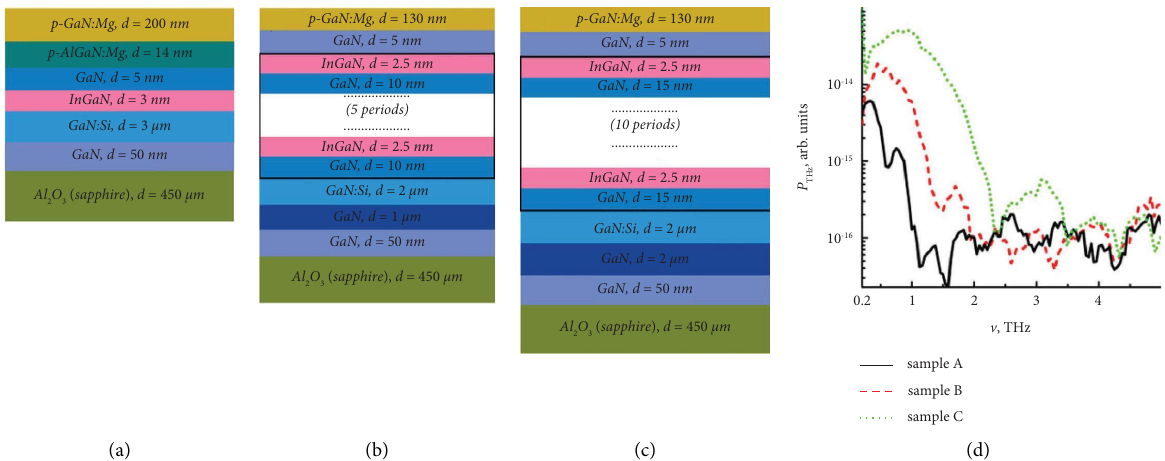
Figure 2: (a) Experimental samples with (a) one, (b) fve, and (c) ten InGaN/GaN quantum wells. (d) Terahertz emission spectra generated in samples A, B, and C under the excitation power densities which provide maximal energy of the THz signal. Reprinted with permission from [26]. Reproduced with permission from Wiley materials. Copyright Wiley